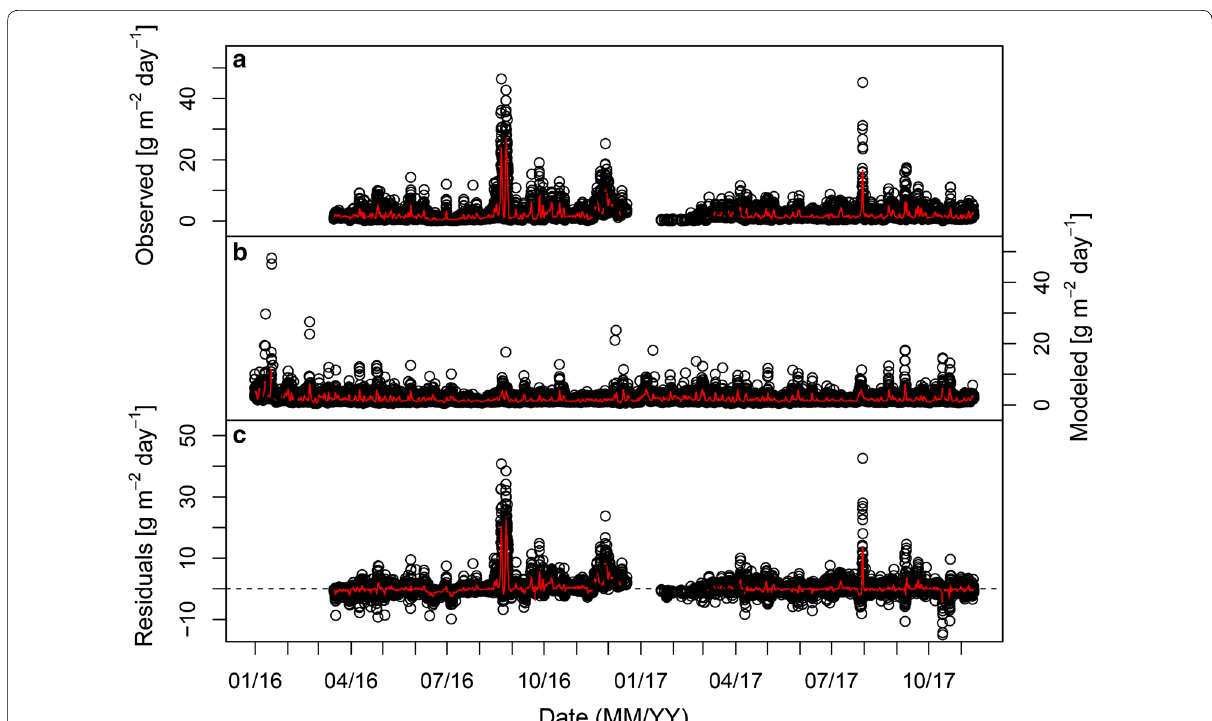
Fig. 8 a Observed and b modeled time series of soil CO 2 flux and c residuals of soil CO 2 flux. The red line shows the daily average values of the data. The dotted line corresponds to the zero level of the